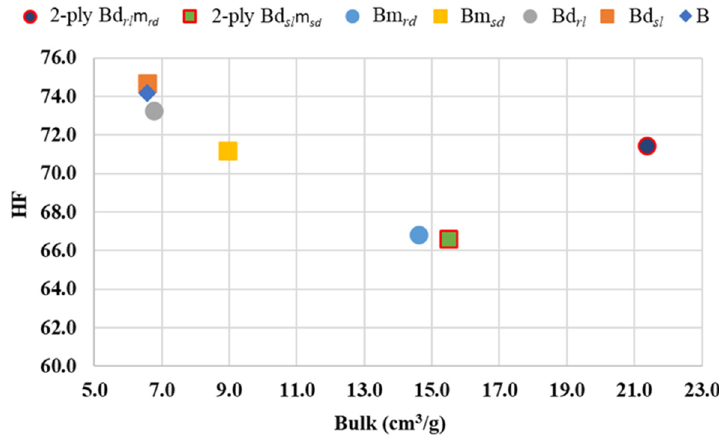
Figure 17. Handfeel (HF) behavior as a function of bulk.